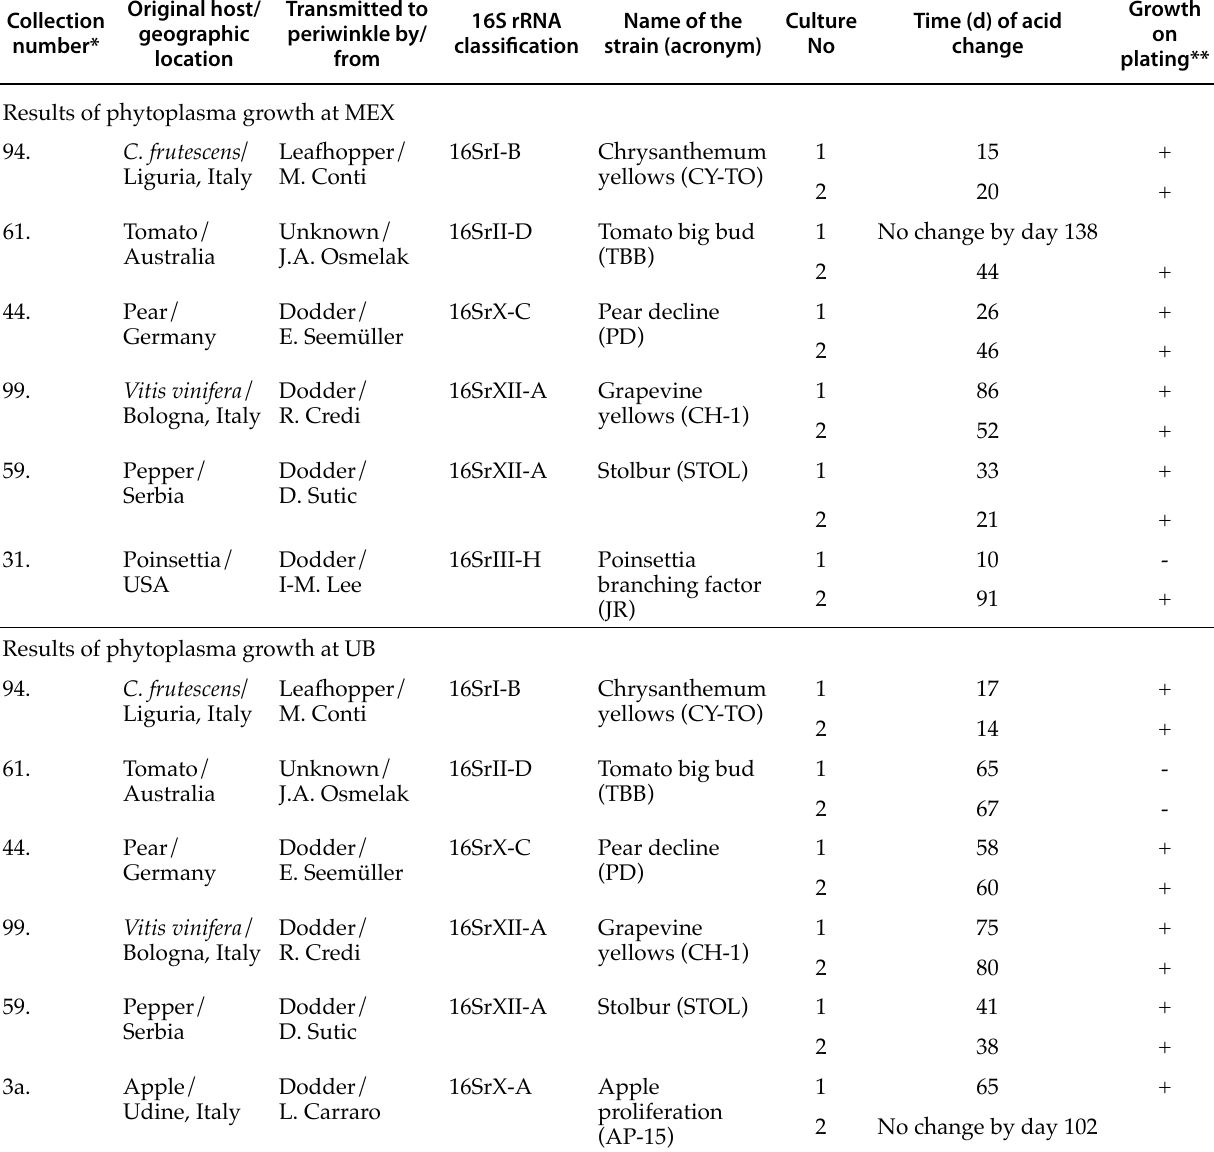
Table 1. Results of phytoplasma growth from infected micropropagated periwinkle shoots in agar medium at MEX and at UB. Collection